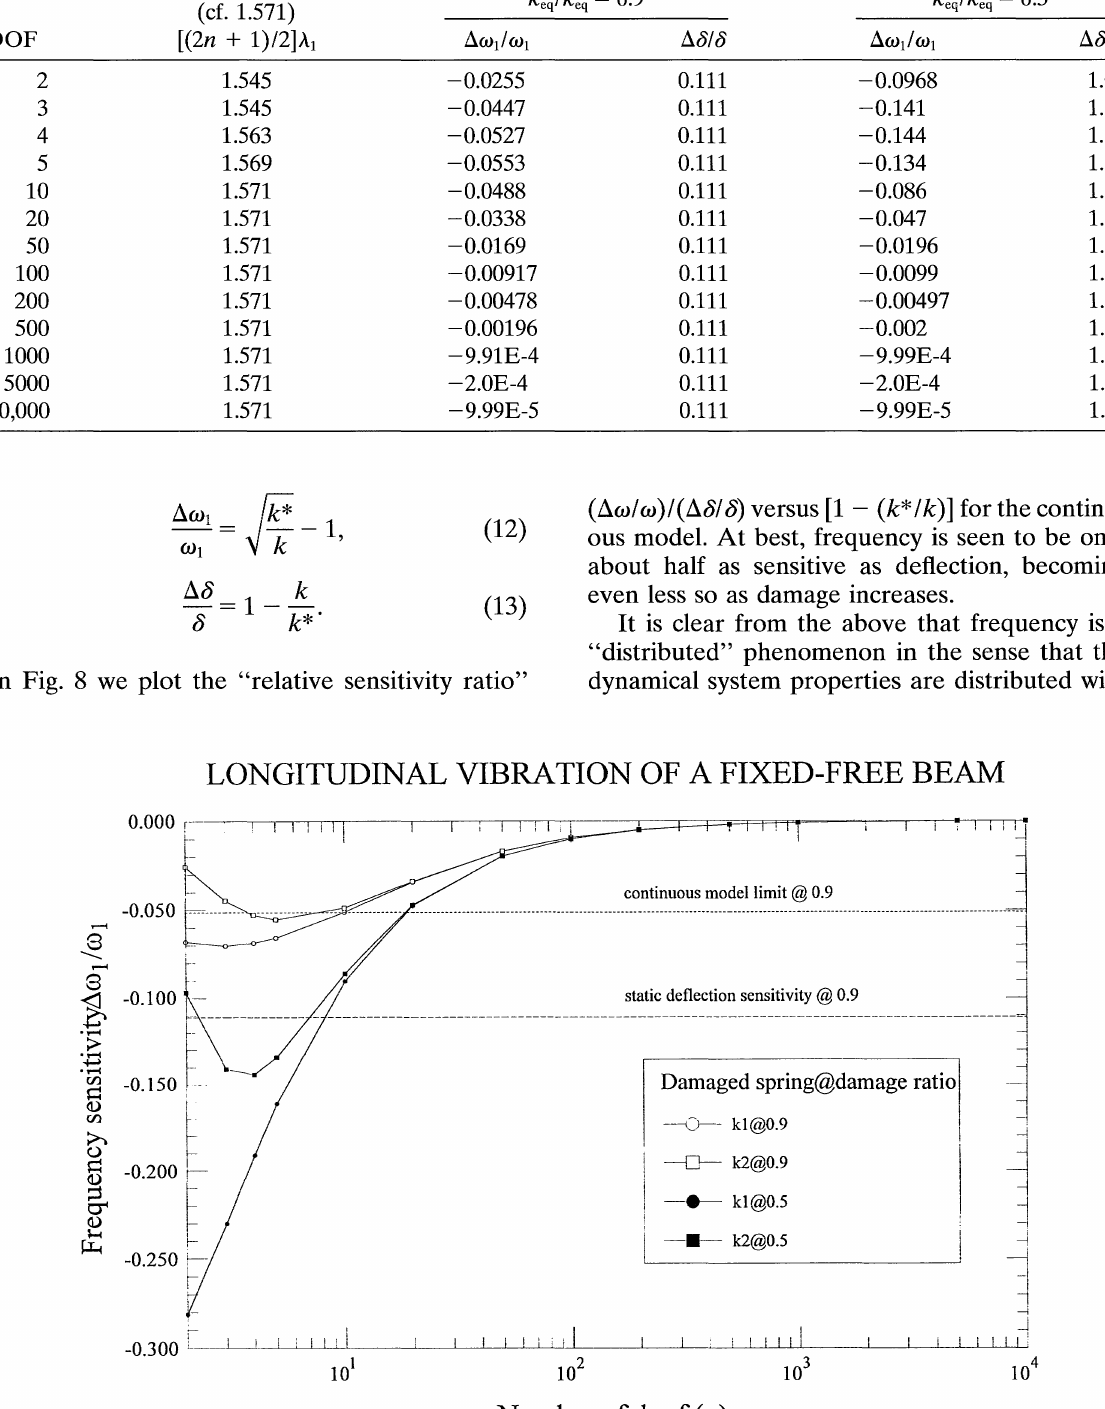
FIGURE 6 Frequency sensitivity for the longitudinal vibration of a lumped parameter fixed-free beam for various damage ratios and damaged springs, and extended in the limit toward the continuous